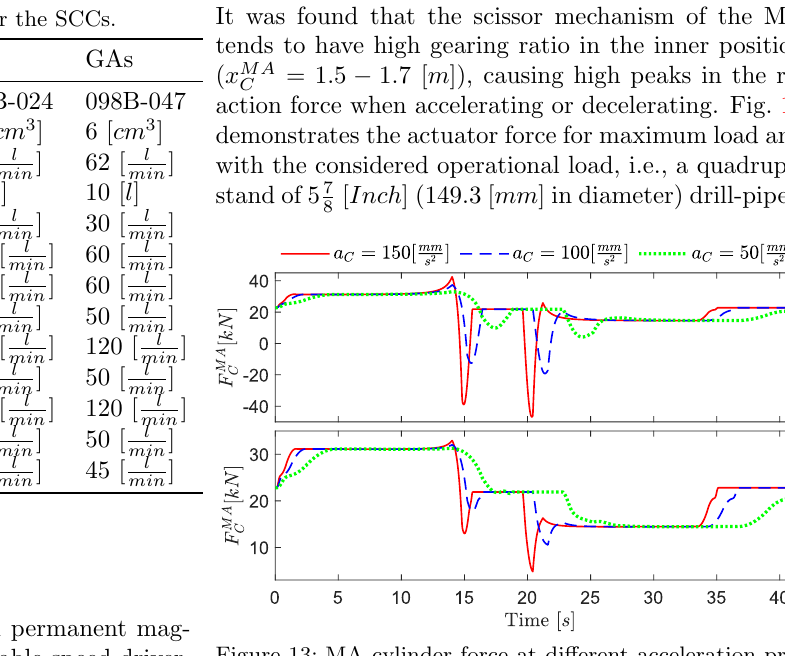
Figure 13: MA cylinder force at different acceleration pro- files: (top) with max payload (14 [ mT ]); (bottom) with normal operational payload (1.5 [ mT ]). To reduce the force peak, the acceleration set-point ( a C = 50 [ mm ], green line in Fig. 13) is chosen as s 2 SP low as possible for the given stroke length and